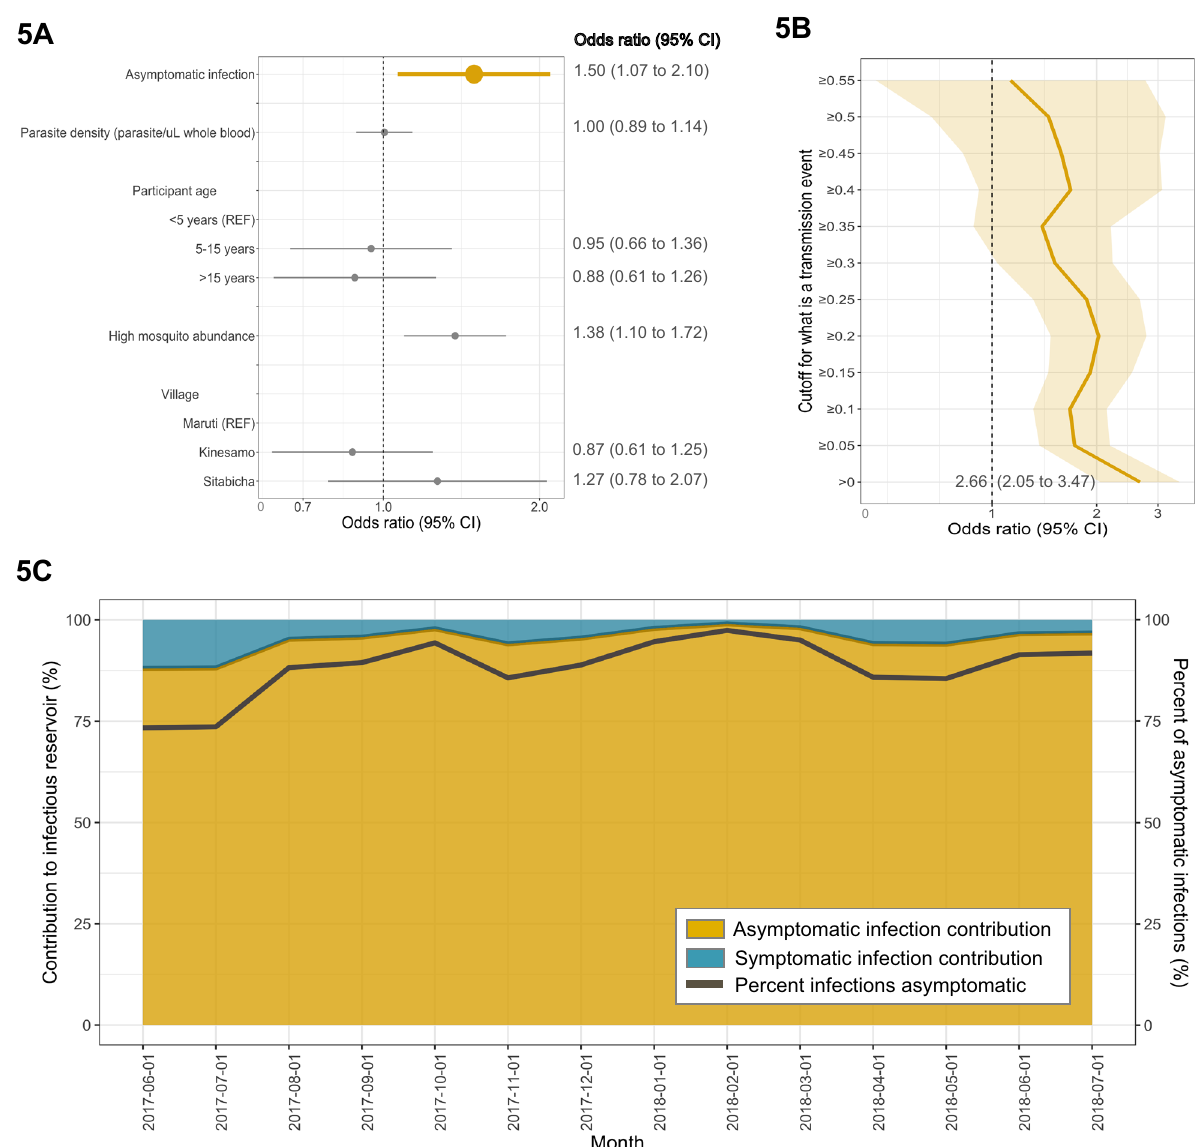
Fig. 5 Multi-level logistic regression results for the odds of a participant-to-mosquito malaria transmission event from participants with asymptomatic compared to symptomatic infections using the pfcsp gene target. A Odds ratios (ORs) of the probability of malaria transmission events from infected participants to mosquitoes ( N = 3727 participant – mosquito pairings). ORs were computed using a multi-level logistic regression model with the probability of transmission outcome coded continuously. Values >1 indicate a factor that is associated with a greater likelihood of transmission of parasites to a mosquito, while values <1 indicate a lesser probability. Data are presented as odds ratios (dots) with 95% con fi dence intervals (bars). B ORs of the probability of transmission from infected participants to mosquitoes were re-estimated using multi-level logistic regression models with the outcome coded dichotomously ( N = 3727 participant – mosquito pairings). Models were computed iteratively by dichotomizing the probability of transmission at increasing values from 0.00 to 0.55, thereby increasing the stringency of the de fi nition of a transmission event. The dark yellow line indicates the OR at each dichotomized level of the probability outcome, and the shaded area indicates the 95% con fi dence interval around each OR. C The contribution to the infectious reservoir was calculated using the odds of transmission to mosquitoes from participants with asymptomatic compared to symptomatic infections each month. The yellow area indicates the percentage of asymptomatic infections that contributed to the infectious reservoir, whereas the blue area indicates the percentage of contribution of symptomatic infections. The dark gray line indicates the percentage of infections that were asymptomatic each selected based on their high malaria prevalence in a previous cross-sectional Verbal assent was also obtained from children between 8 and 18 years. The study study 61 . All household members in participating households over the age of 1 year was approved by the ethical review boards of Moi University (2017/36), Duke were offered enrollment. Sample collection details have been reported 62 . For each participant, demographic and behavioral questionnaires were administered and dried blood spot (DBS) samples were collected every month. The DBS were tested for P. falciparum parasites using real-time PCR post hoc (see below), and therefore parasites detected in asymptomatic people were not treated. Participants contacted the study team at any time when experiencing symptoms consistent with malaria, at which time they were tested for malaria using a rapid diagnostic test (RDT)